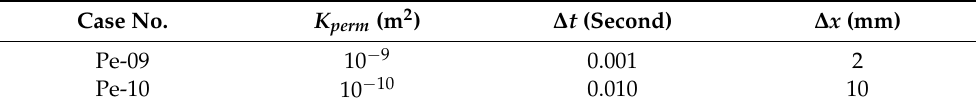
Table 1. Boundary conditions of variable head permeability test.